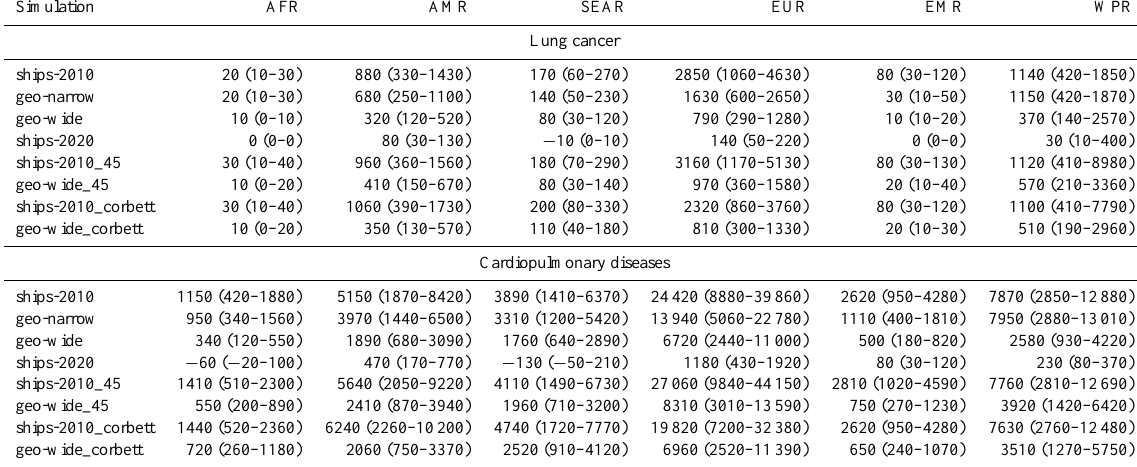
Table 3. Regional annual premature mortality due to shipping emissions in different scenarios (deaths per year) ∗